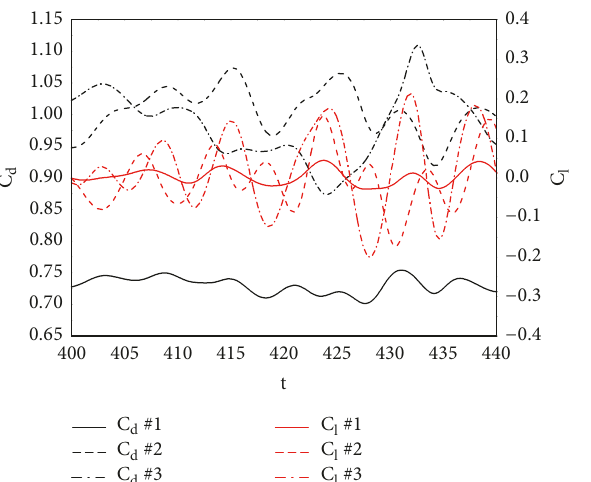
Figure 19: Temporal evolution curve of lift and drag coefficients for three cylinders at 𝑆/𝐷 = 8.0 .